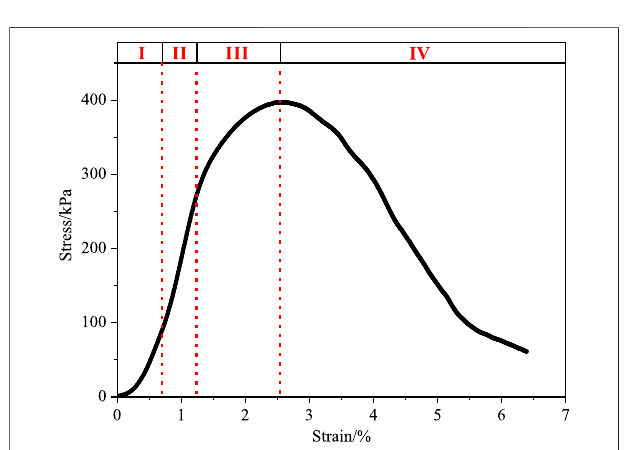
FIGURE 7 | The stress – strain curve of uniaxial